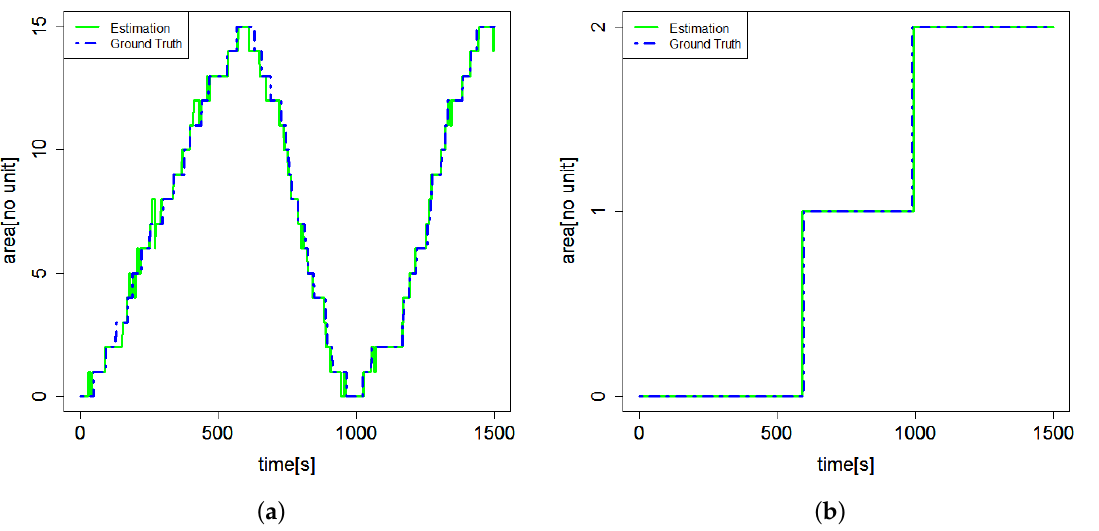
Figure 5. The result of the position estimation. ( a ) shows the X -position section label. ( b ) shows the Y -position section